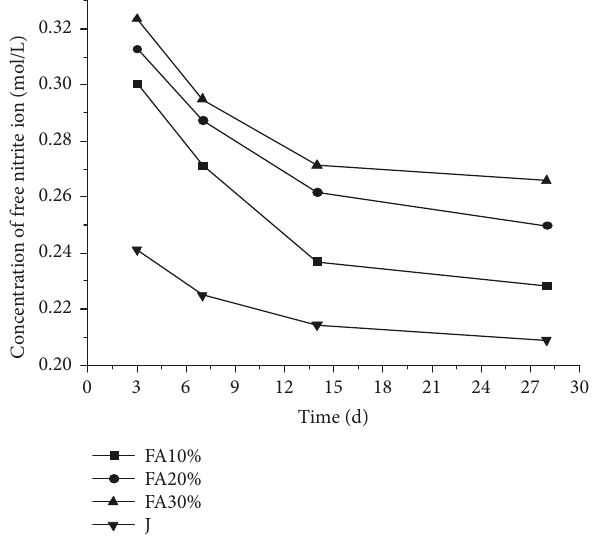
Figure 2: The free nitrite ion concentration curves of specimens A1- A3 and reference (J)